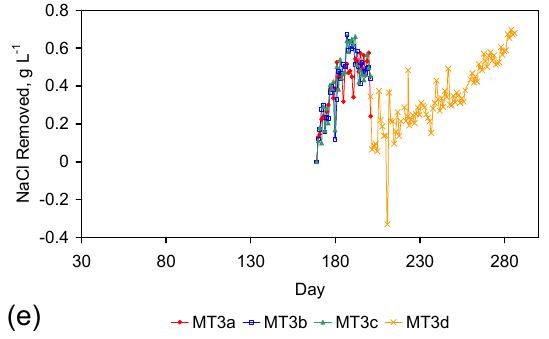
Figure C15. ( a ) EC vs. day; ( b ) Eh vs. day; ( c ) pH vs. day; ( d ) pH vs. Eh; ( e ) NaCl Removed (calculated from EC and residual water volume) vs. day. MT3a = 73.5 g·L − 1 ; MT3b = 62.6 g·L − 1 ; MT3c = 52.6 g·L − 1 ; MT3d = 62.9 g·L − 1 . Reactor Size (MT3a–MT3c): 2.3 L; Feed